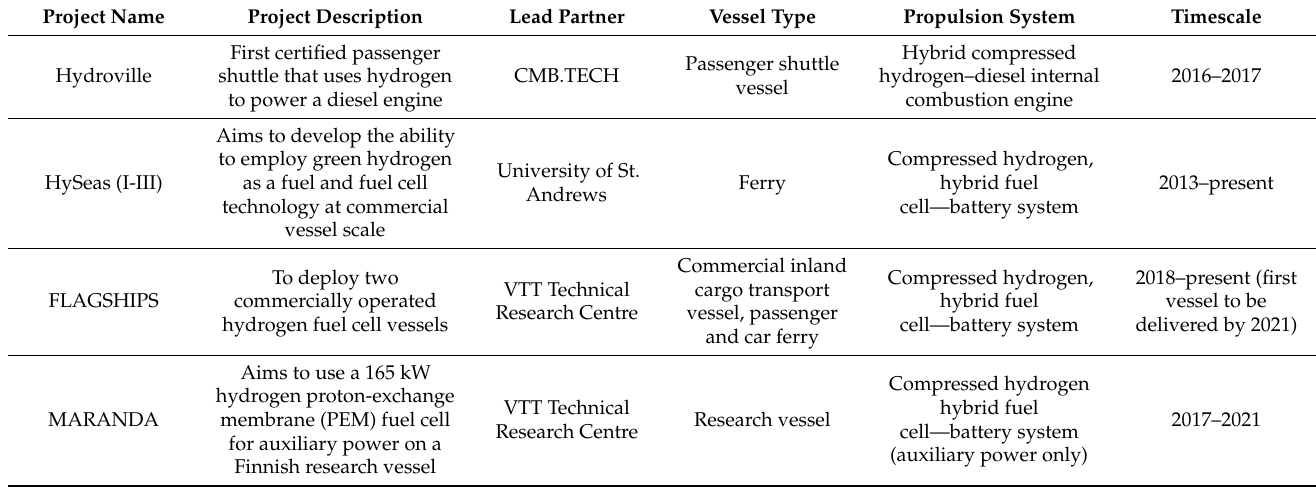
Table 1. Summary of hydrogen-powered propulsion